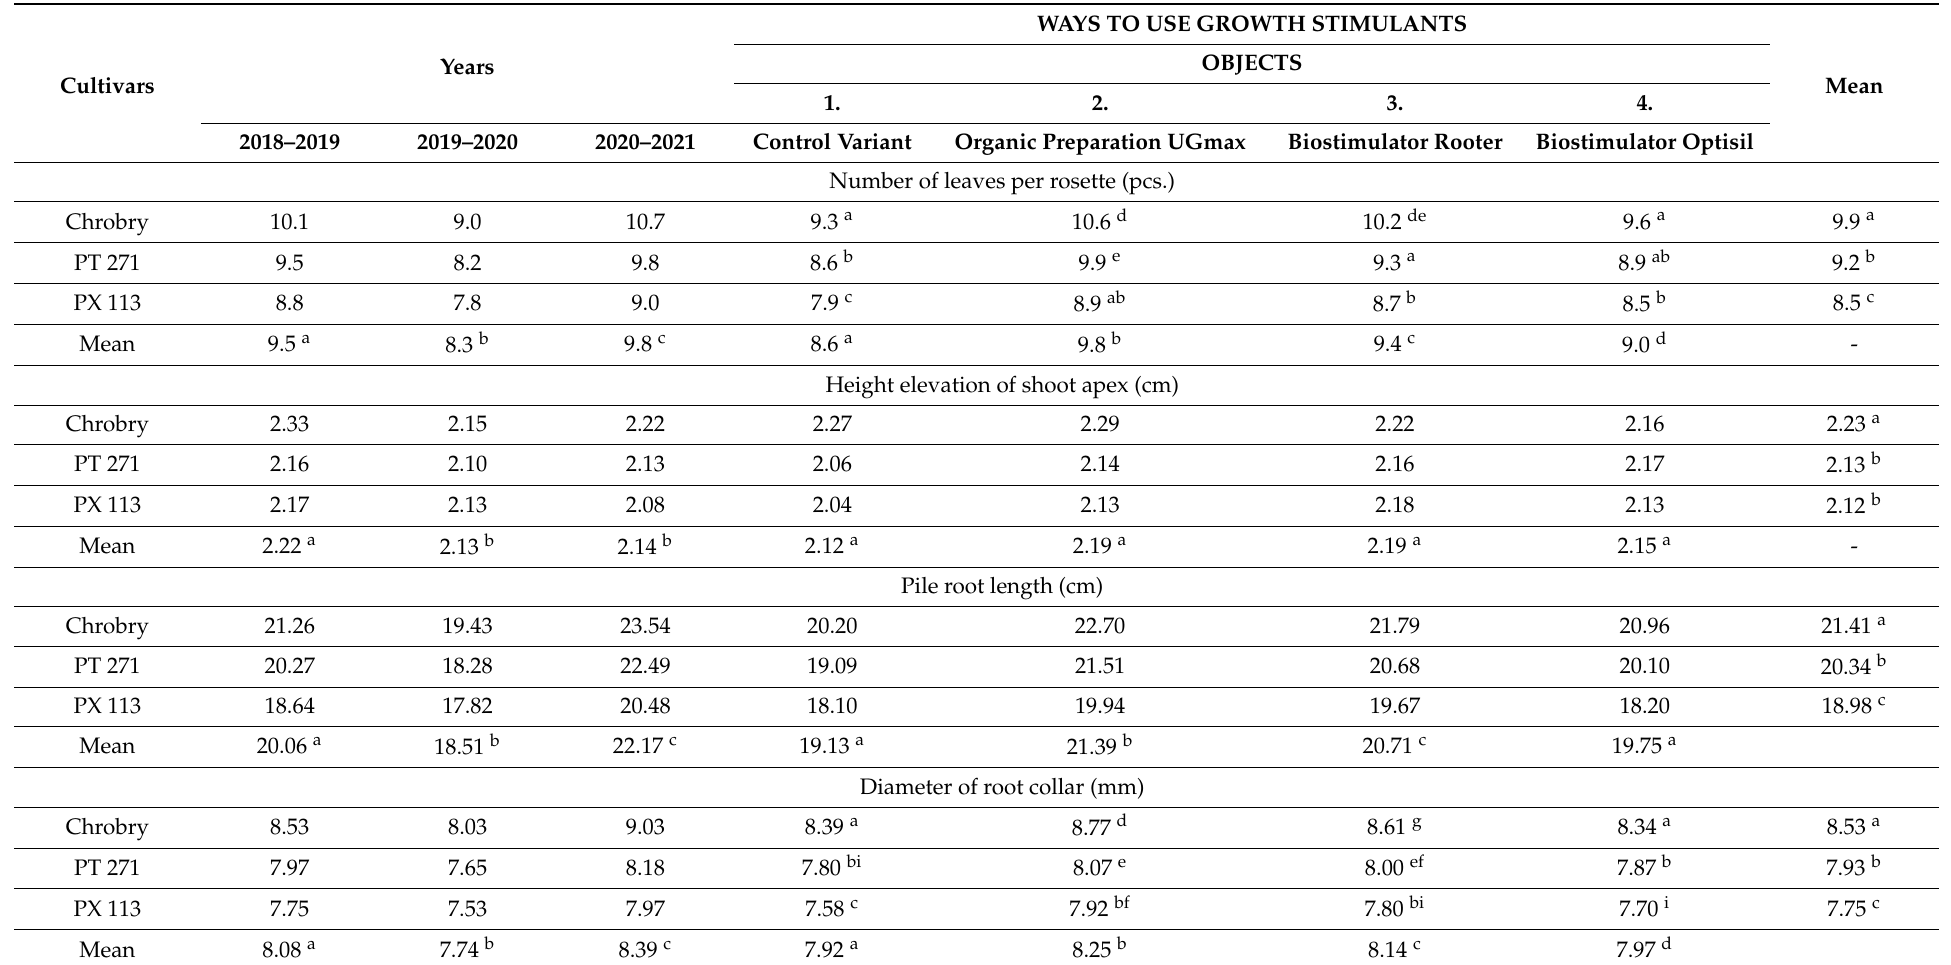
Table 2. Morphological features of winter rape cultivars depending on the factors of the